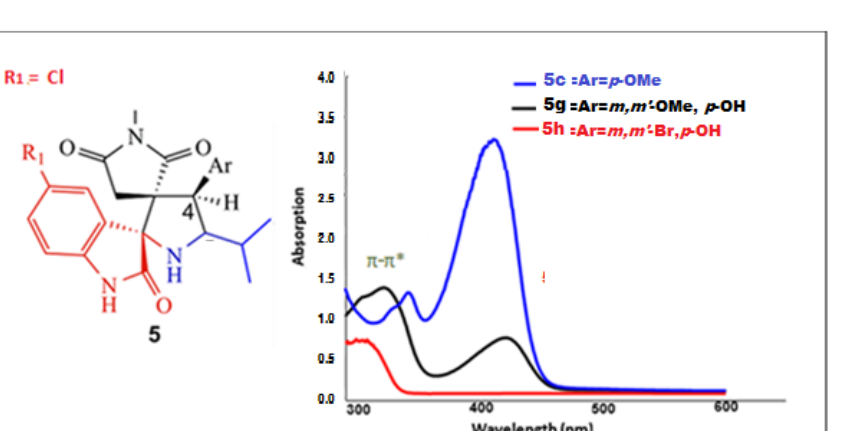
Figure 5. UV-visible absorption spectra in DMSO (c = 10 −5 M) at 298 K of compounds 5c , 5g and 5h .